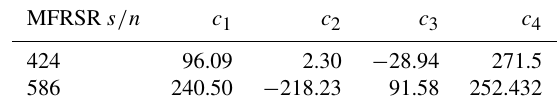
Table 2. Coefficients, in Wm − 2 , of the linear fit between PAR and MFRSR calibrated signals for the four-band linear